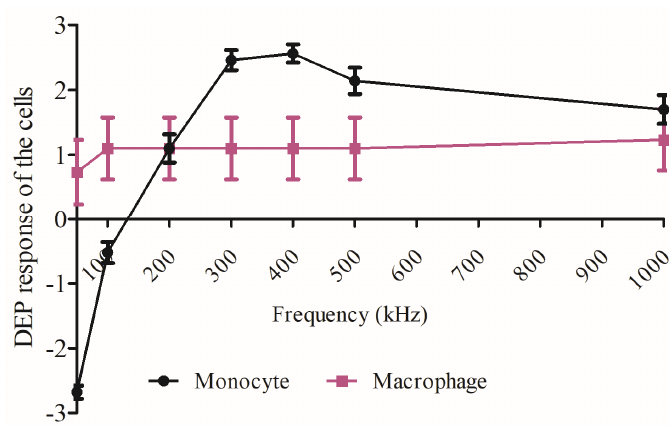
Figure 2. Dielectrophoretic responses of monocytes and macrophages: ( a ) Positions of the cells in the electrode array when they are influenced by nDEP, crossover frequency (CF) and pDEP, respectively; ( b ) Translational movement of U937 monocytes under 20 Vpp, 50 kHz–1 MHz nonuniform AC field; ( c ) Translational movement of U937-differentiated macrophages under 10 Vpp, 50 kHz–1 MHz nonuniform AC field. The cool colors show the number of nDEP- behaved cells due to repelling DEP forces while the warm colors demonstrate pDEP-responded cells owing to attractive DEP forces. Zero means the crossover frequency with zero movements, which is coded in green color. n = 80 for monocytes, n = 30 for macrophages.